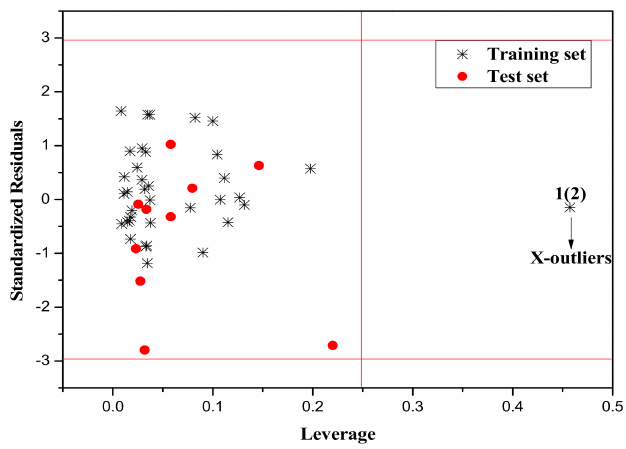
Figure 4. The William’s plot for the training and test set compounds of Group 1 by MLR model.